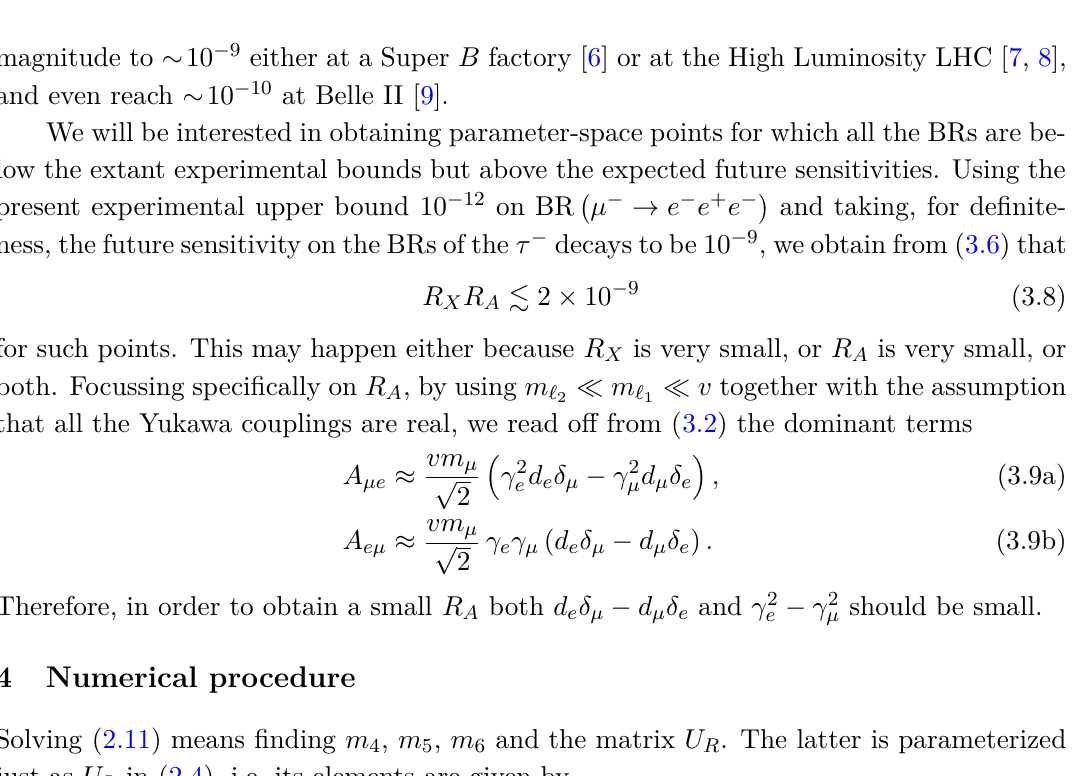
Table 1 . The experimental upper bounds on the branching ratios. The bounds are 90% CL and have been taken from